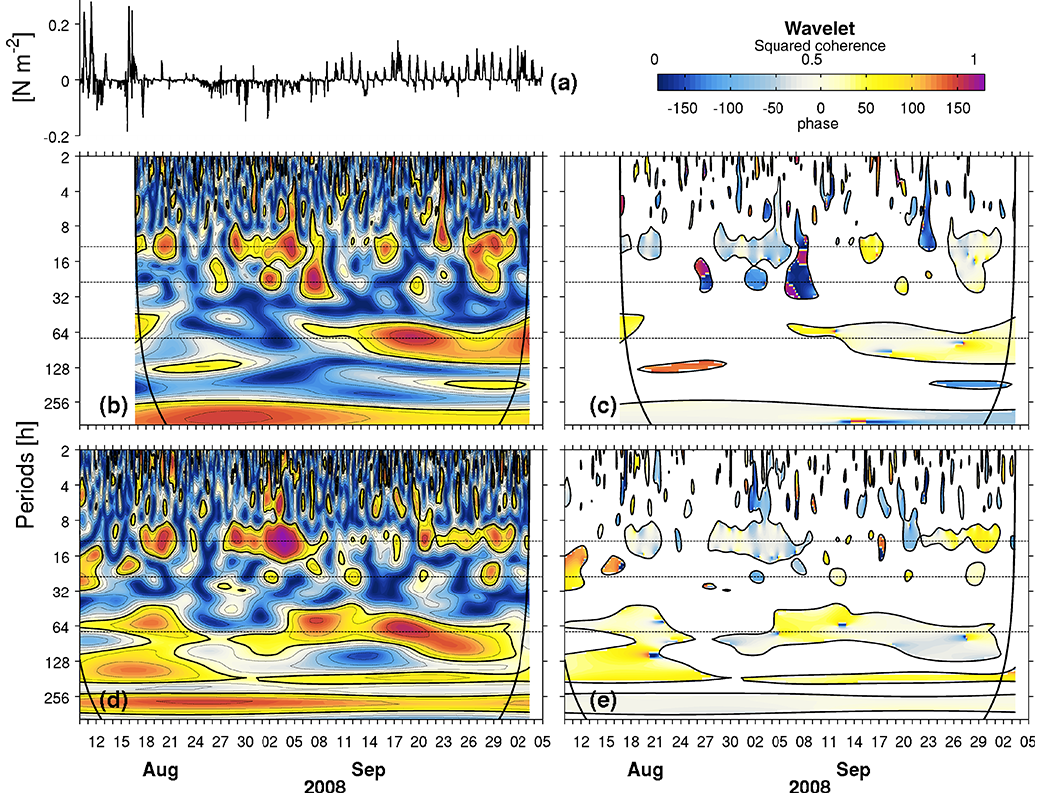
Figure 8. Coherence and phase wavelet spectra. (a) Time series of along-fjord wind stress, and (b, c, d, e) coherence and phase wavelet spectra, for the relations mouth–Puelo (b, c) and Puelo–Cochamo (d, e) . In the contours, the thick black line indicates squared coherence ≥ 0.6; only the associated phases were present on the phase wavelet. The thick black curve is the influence cone for the wavelet